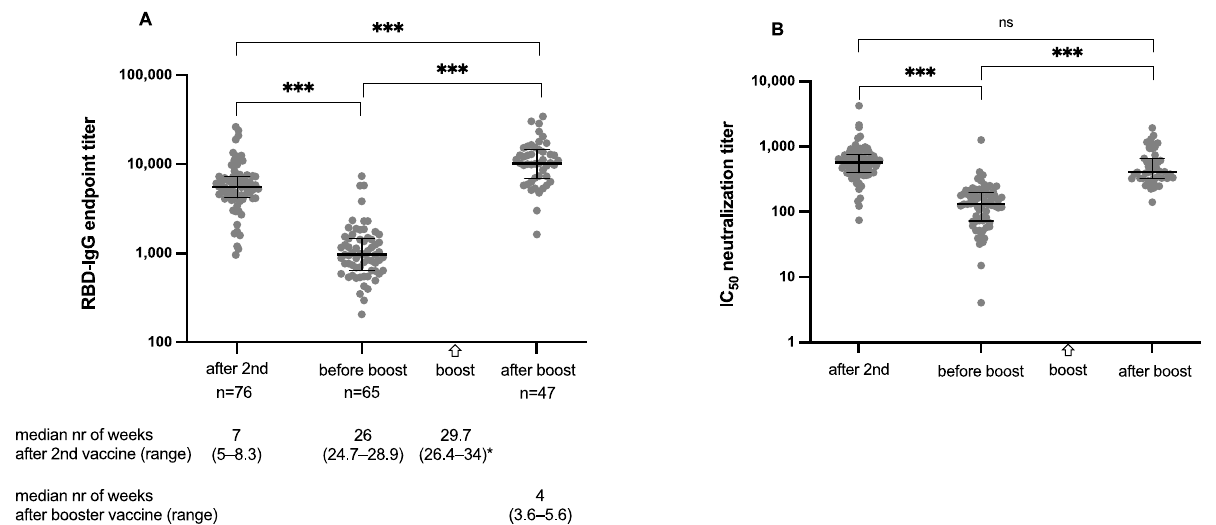
Figure 1. Waning immunity over time and effect of booster vaccination: 26 weeks after BNT162b2 basic immunization, receptor-binding-domain (RBD) IgG titers and neutralization capacity significantly decreased. By booster immunization, a significant increase in both parameters could be induced. Shown are individual IgG endpoint titers and median with interquartile range as measured by wild-type (WT) RBD ( A ) and neutralization capacity ( B ) given as half maximal inhibitory concentration (IC 50 ) as measured by WT pseudovirus assay. For statistical analysis, Wilcoxon tests for paired values were performed. 2 missing values. *** p < 0.001; ns = not significant